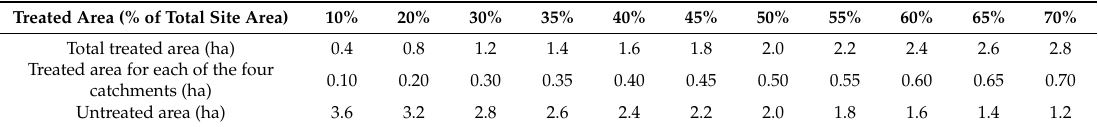
Table A5. Areas of the treated and untreated parts of the catchment that were studied. Treated Area (% of Total Site Area)